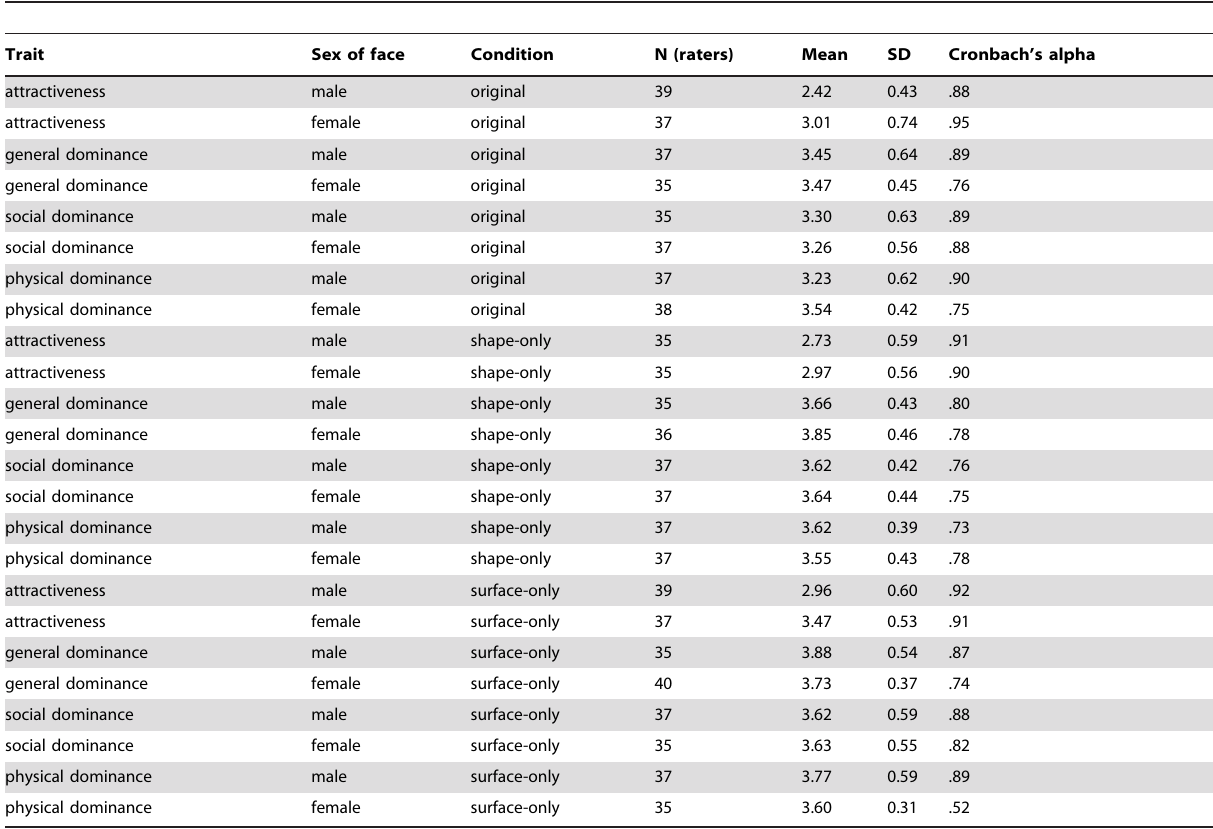
Table 1. Means and SDs for ratings of the attractiveness, general dominance, social dominance, and physical dominance of original, shape-only, and surface-only versions of male and female